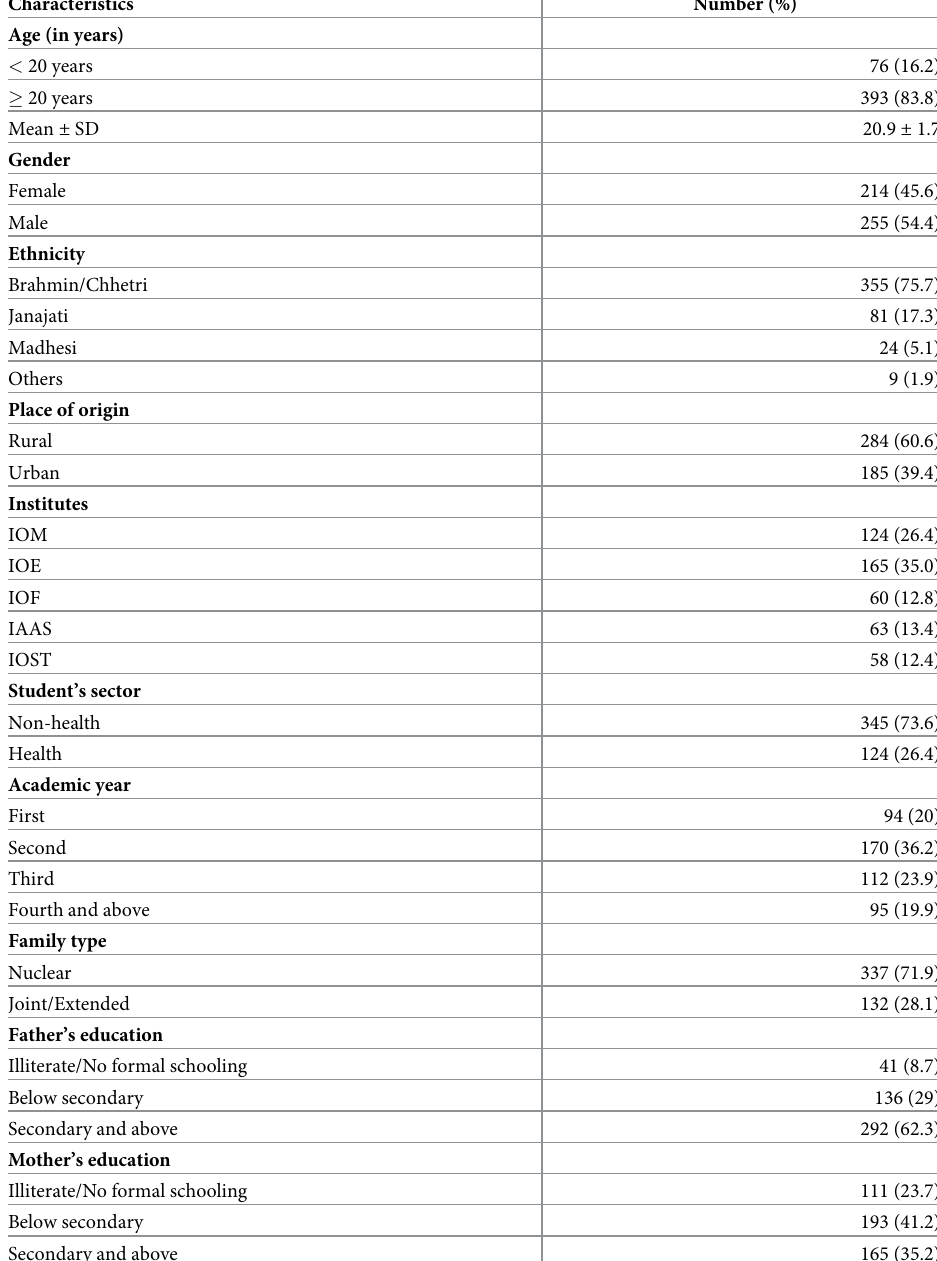
Table 1. Characteristics of the participants (n = 469).